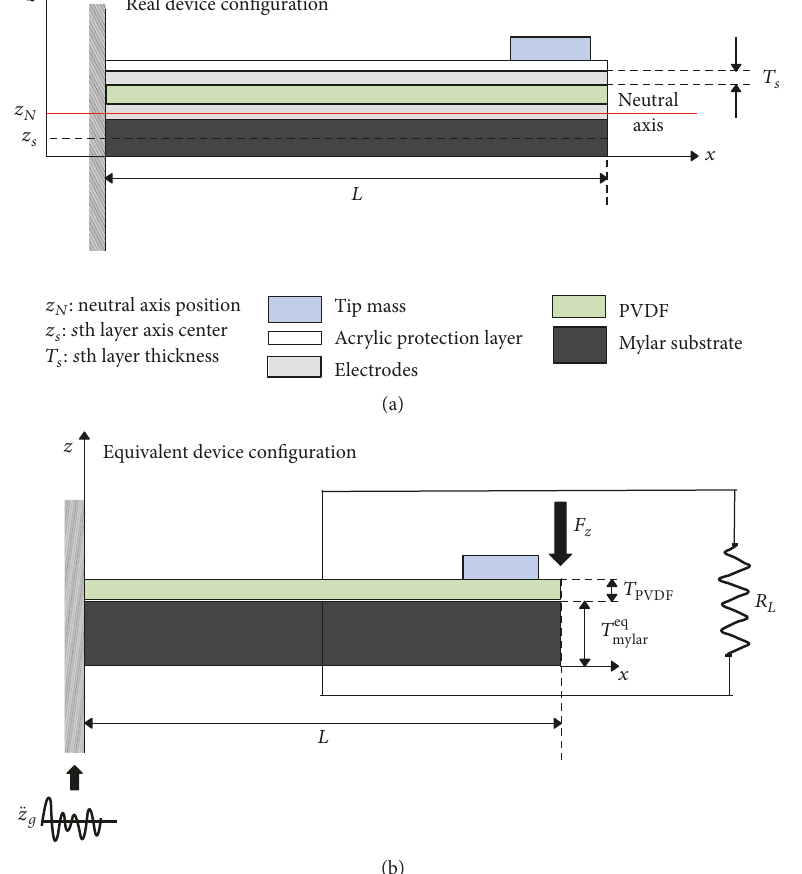
Figure 1: Schematic representation of the unimorph electromechanical generator with a piezoelectric layer made of PVDF.